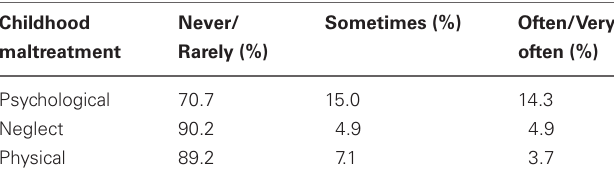
Table 1 | Percentage of childhood maltreatment